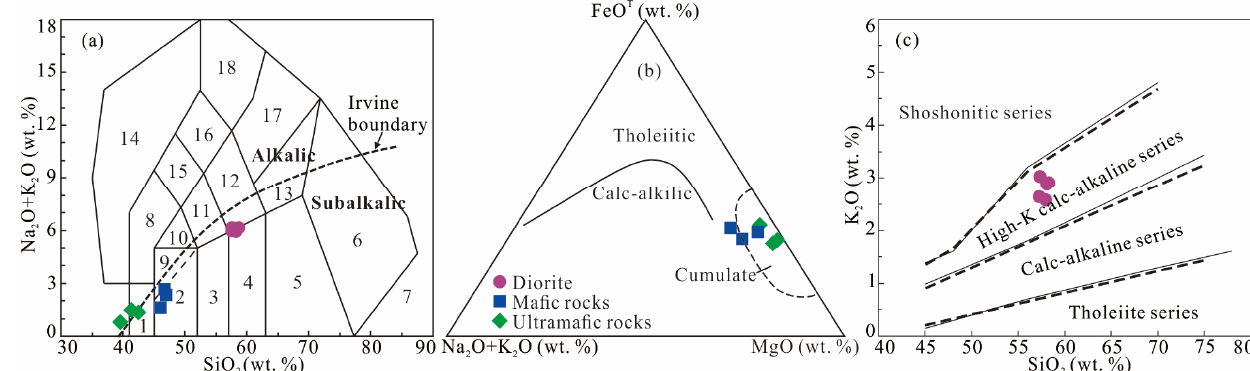
Figure 6. Major element geochemical diagrams of ( a ) SiO 2 versus (Na 2 O+K 2 O) (modified after [47]), ( b ) FeO T − (Na 2 O+K 2 O) − MgO (modi fi ed after [48]) and ( c ) SiO 2 versus K 2 O (modified after [49]) for